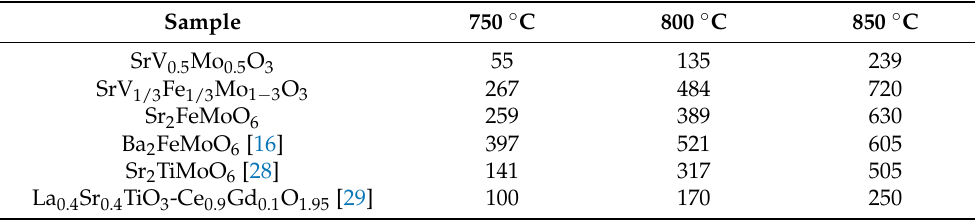
Figure 5. Comparison of the cell voltage and power density testing at 750 − 850 °C as a function of current densities for single cells with ( a ) SVMO, ( b ) SVFMO and ( c ) SFMO as anodic material. ( d ) Evaluating the long-term stability of the three anode materials testing in 0.7 V at 750 °C. Table 3. Power density (mW cm − 2 ) for single cells with SVMO, SVFMO and SFMO as anodic material at different temperatures.